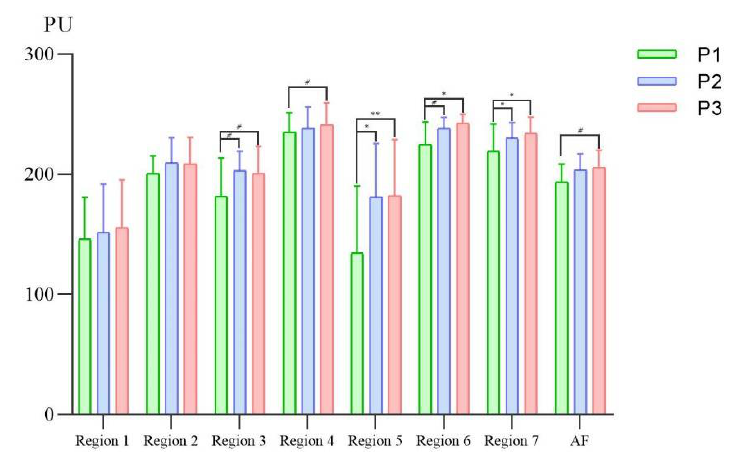
Figure 3. Bar plots of facial skin blood flow of the affected face before and after peripheral magnetic stimulation in stroke patients with facial paralysis. P1, 0–5 min before the PMS intervention; P2, 0–5 min after the PMS intervention; P3, 6–10 min after the PMS intervention; AF, the affected face; PU, perfusion index. #, 0.05 < p < 0.1; *, 0.01 < p < 0.05; **, p < 0.01.